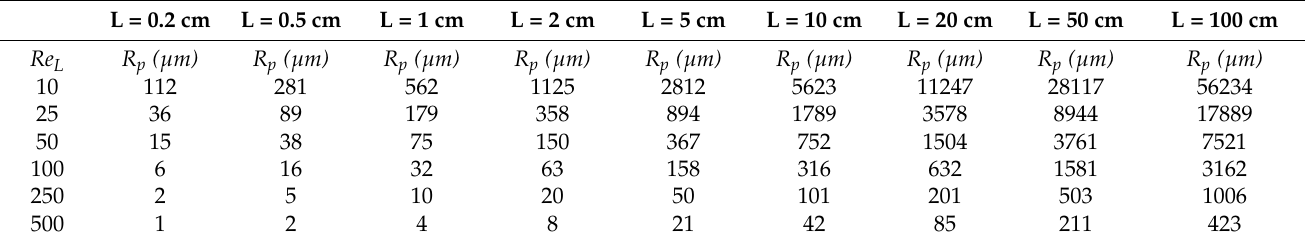
Table 1. Maximum dimensions for small neutrally buoyant particles ( R p < L/Re L 5/4 ) in boundary layer (BL) at solid plates of various length